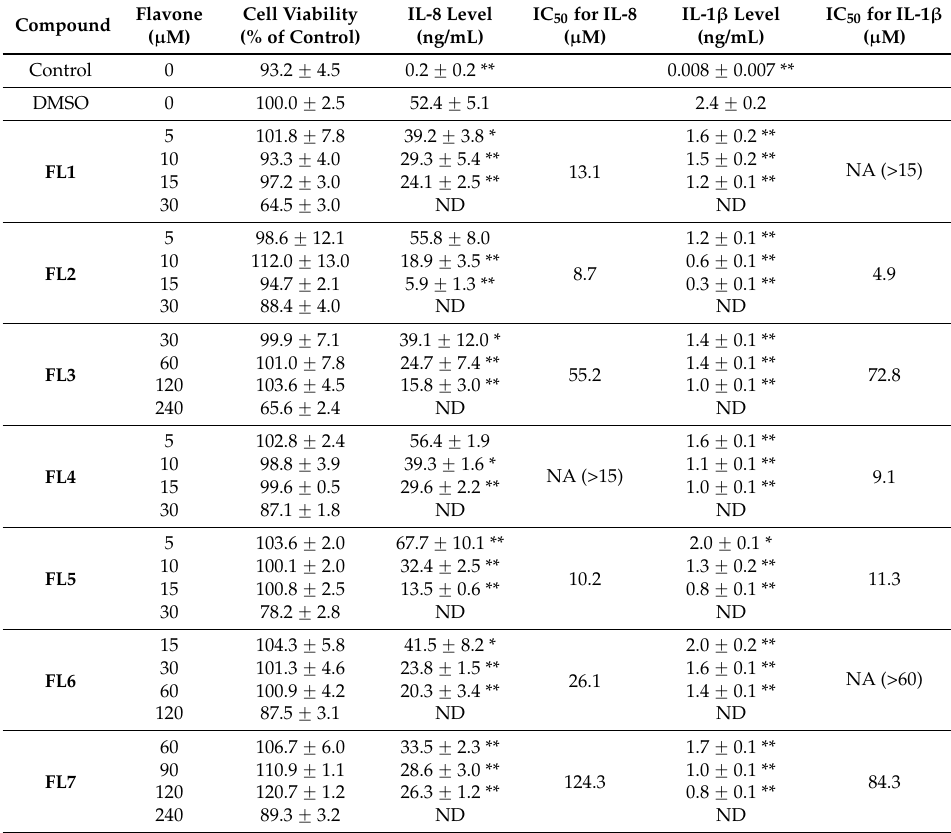
Table 1. Effects of flavones isolated from Scutellariae radix on the cell viability and P. acnes -induced cytokine production of THP-1 cells.